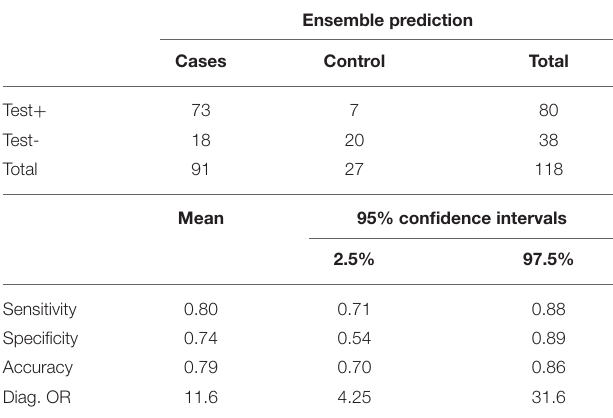
TABLE 6 | Ensemble performance of ML-based PCS diagnostic